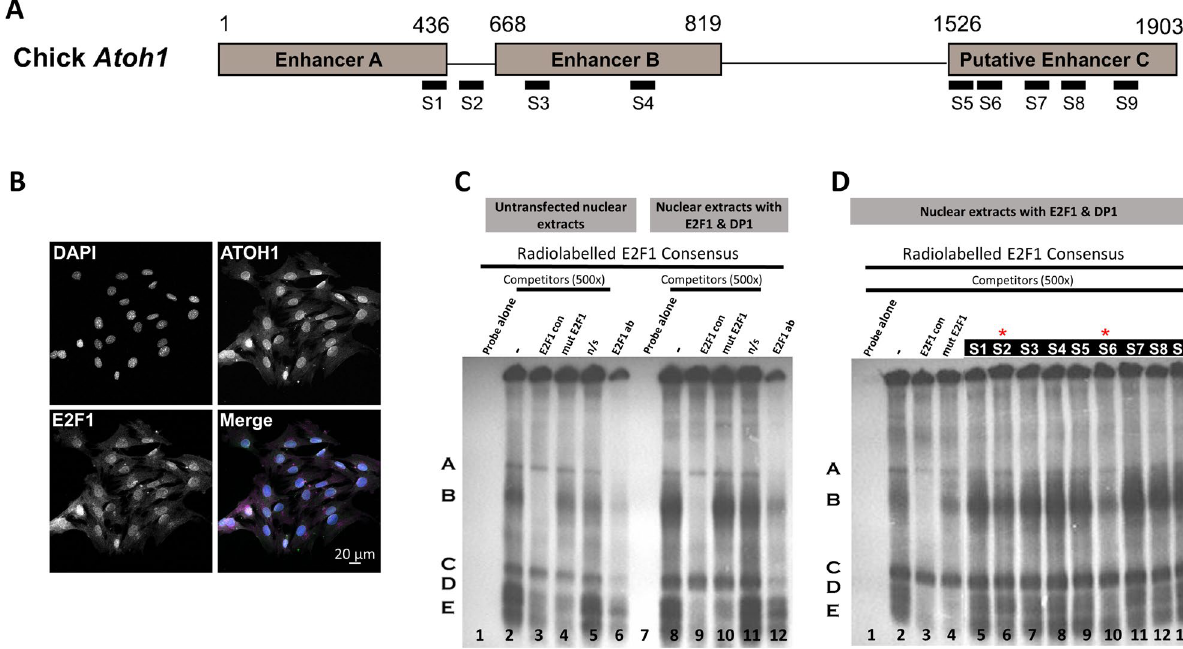
Figure 3. Identification and verification of E2F recognition elements in the chick Atoh1 conserved elements. ( A ) Schematic diagram showing the location of nine putative E2F binding sites predicted in the chick Atoh1 conserved regions by MatInspector software (labelled as S1–S9) Numbers indicate the position of the enhancers in base pairs. ( B ) Immunofluoresence detection of endogenous expression of ATOH1 (green) and E2F1 (magenta) proteins in UB/OC-2 cells co-stained with DAPI (blue). ( C ) and ( D ): EMSA analysis performed using a radiolabelled E2F1 consensus sequence, containing a functional E2F1 binding site incubated alone (lane 1), with untransfected nuclear extracts or with nuclear extracts transfected with E2F1 and DP1 expression vectors as indicated. Competition assays were performed with 500 ng of non-radiolabelled competitors (consensus E2F1, lane 3 in both ( C ) and ( D ), and lane 9 in ( C ); mutant E2F1, lane 4 in ( C ) and ( D ), and lane 10 in ( C ); non- specific (N/S) probe, lane 5 and 11 in ( C ); sites S1 to S9 as described in ( A ), lanes 7–15 in ( D ). Lane 6 and 12 show a supershift assay with rabbit polyclonal anti-E2F1, pre-incubated with extracts before the binding